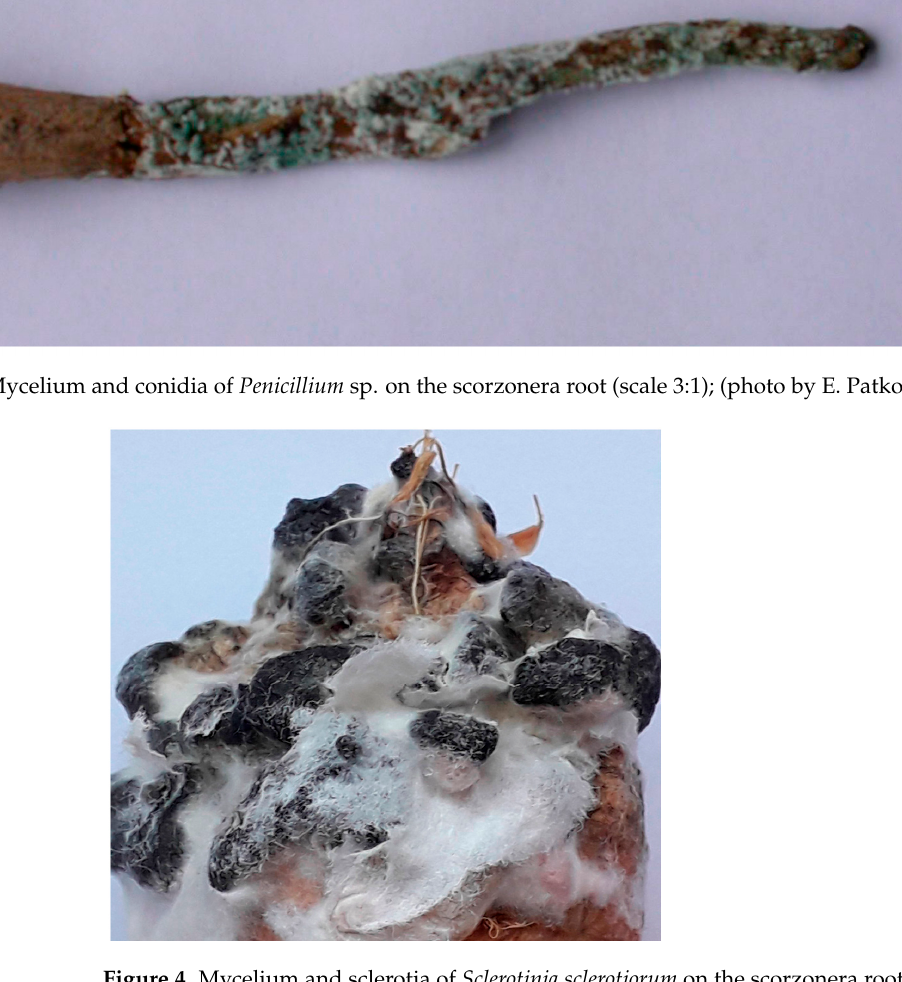
Figure 4. Mycelium and sclerotia of Sclerotinia sclerotiorum on the scorzonera root (scale 3:1); (photo by E. Patkowska).